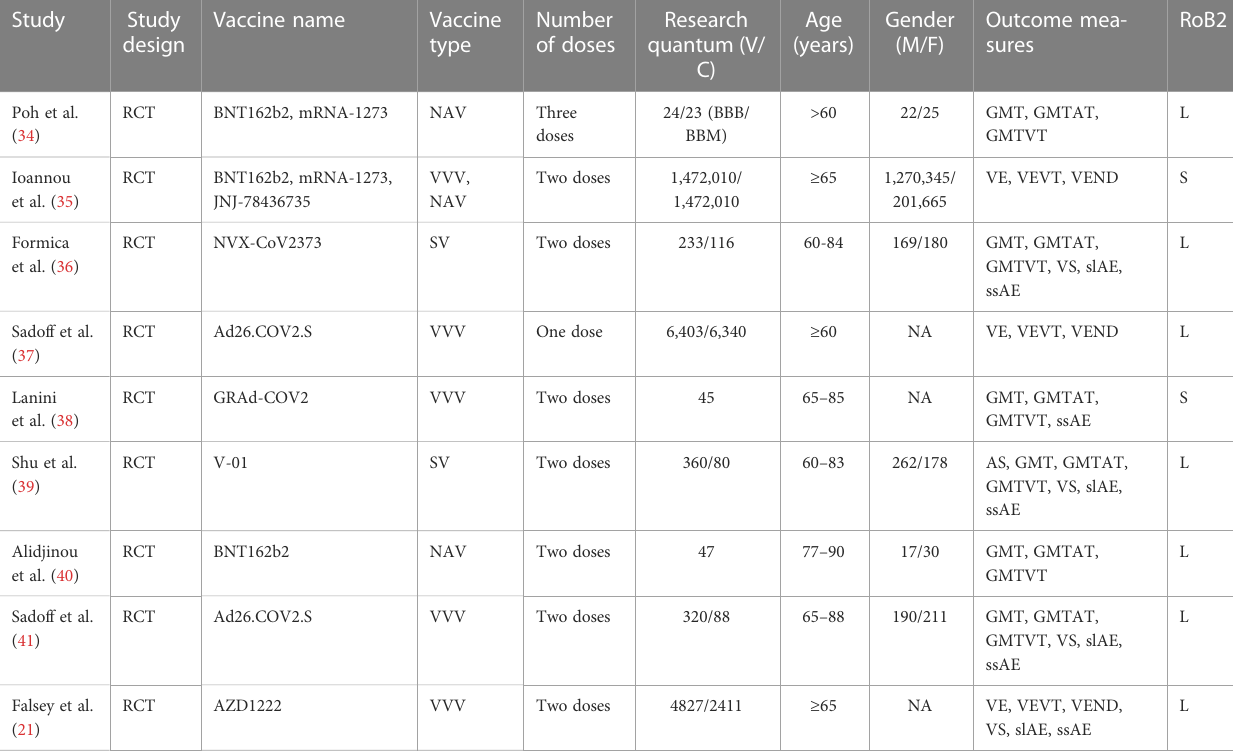
TABLE 1 Basic features of the studies included in the